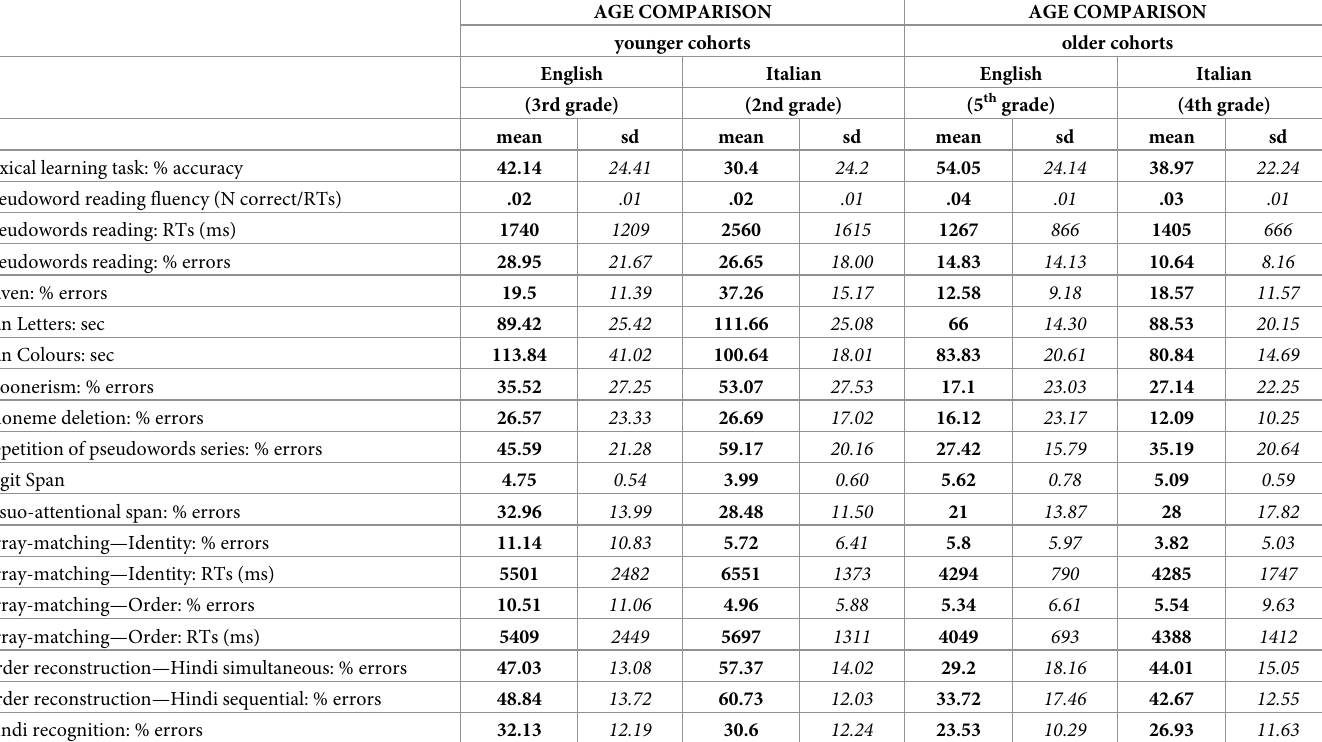
Table 4. Means and standard deviations (SD) for the lexical learning task, as well as the raw scores for all other cognitive tasks. For all measures in the table (except Digit span) higher scores correspond to worse performance (i.e., higher percentage of errors or longer